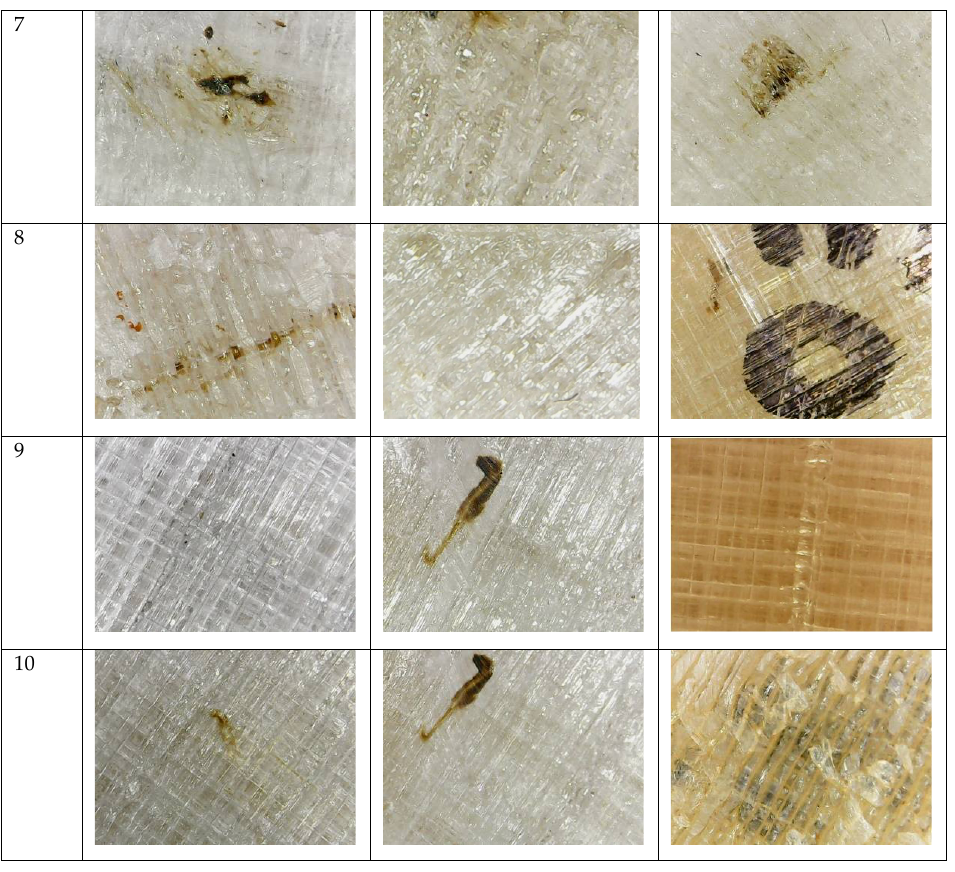
Figure A1. Degradation of PETG.